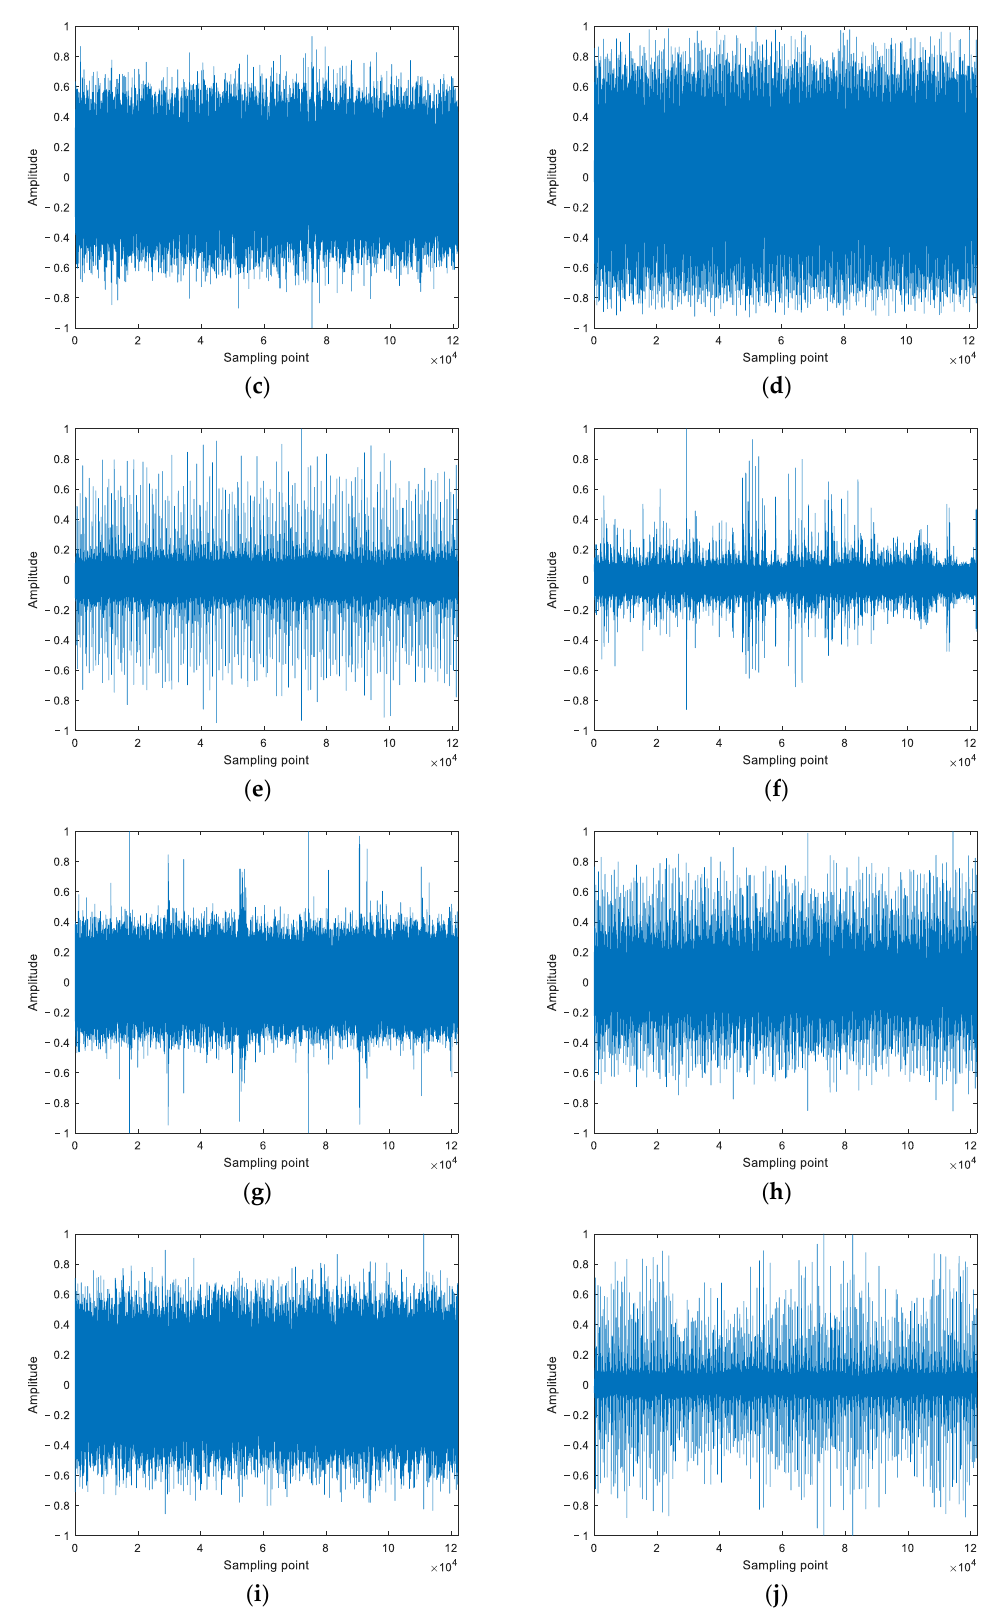
Figure 4. The normalized 10 bearing signals: ( a ) N-100; ( b ) IR-108; ( c ) B-121; ( d ) OR-133; ( e )